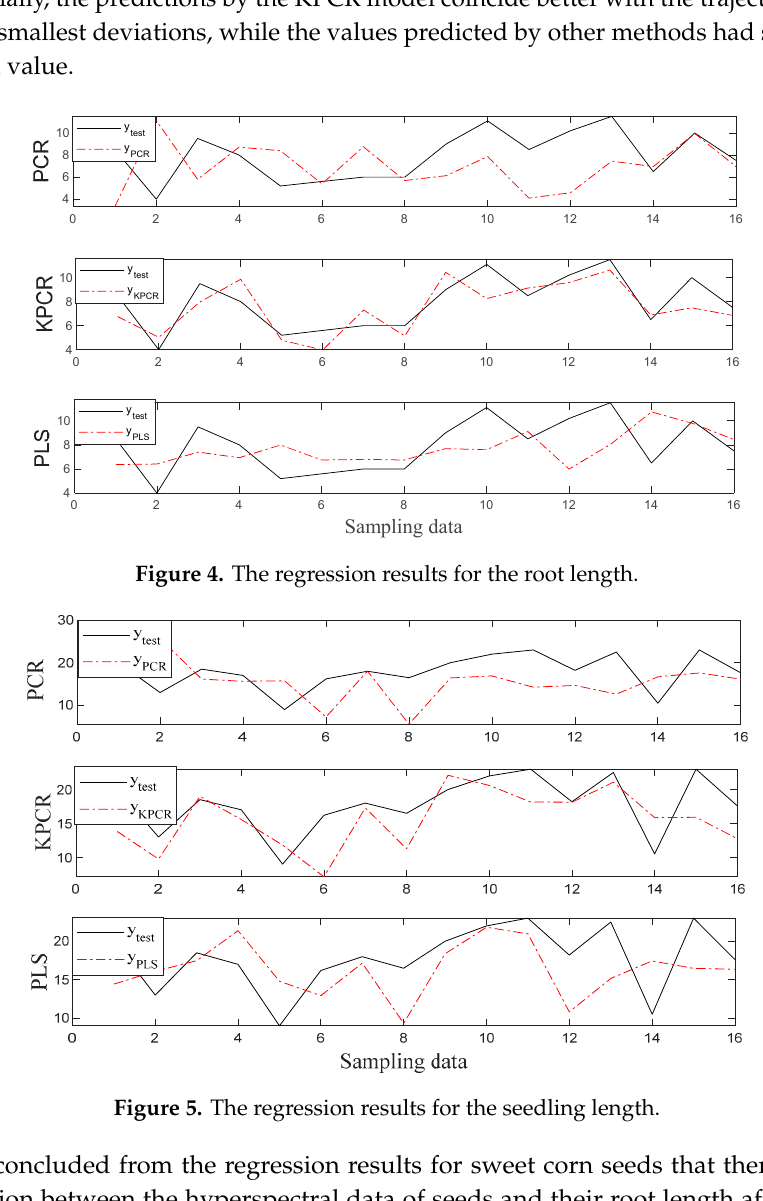
Table 2. Comparison of prediction effect between hyperspectral data and seedling length for corn seeds.